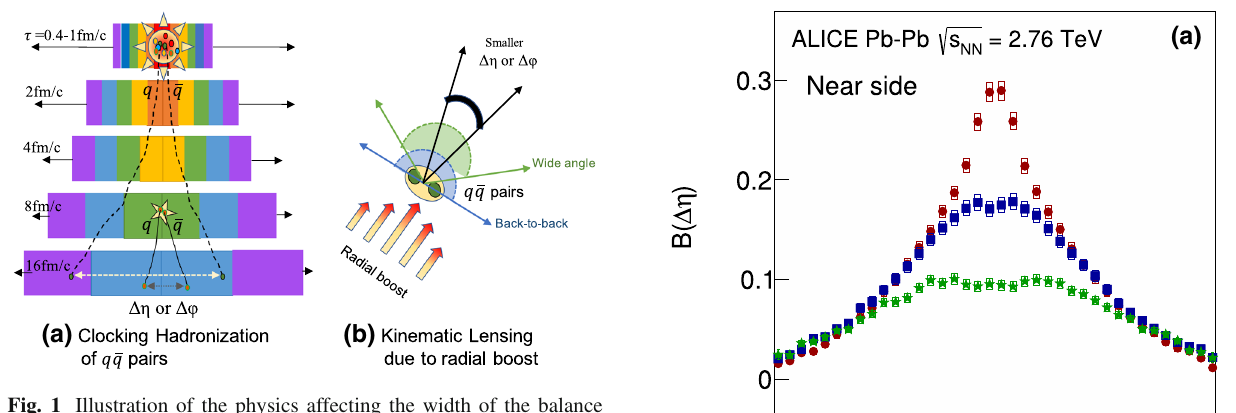
Fig. 1 Illustration of the physics affecting the width of the balance function. a Charges produced early in the collision will be further sep- arated in momentum space than charges produced later (Inspired by Ref. [25]). b Radial flow can lead to a narrowing of the balance func- tionduetokinematiclensingorfocusing(InspiredbyFig.9inRef.[26])